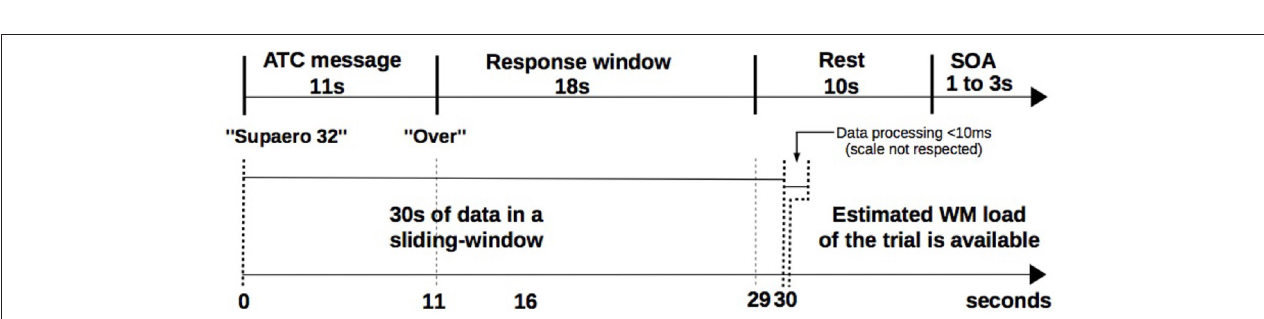
FIGURE 5 | Illustration of the fNIRS based inference system. Pre-recorded ATC messages were sent to the pilot (1). The pilot’s prefrontal activity was measured with a fNIRS device (2). Output measures (3) were MACD-filtered and synchronized with the temporal design of the trial (4). When all of the required data were available for the trial, a request was sent to the pilot’s classifier to assess the WM load of the trial (5).